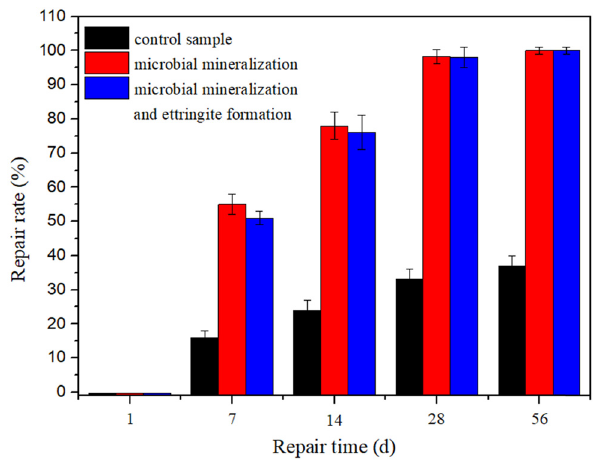
Figure 9: The area repair rate of the crack surface at di ff erent repair times.